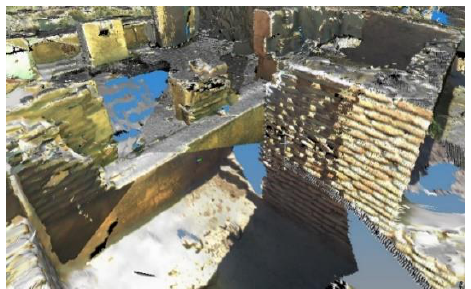
Figure 5. Point cloud after meshing